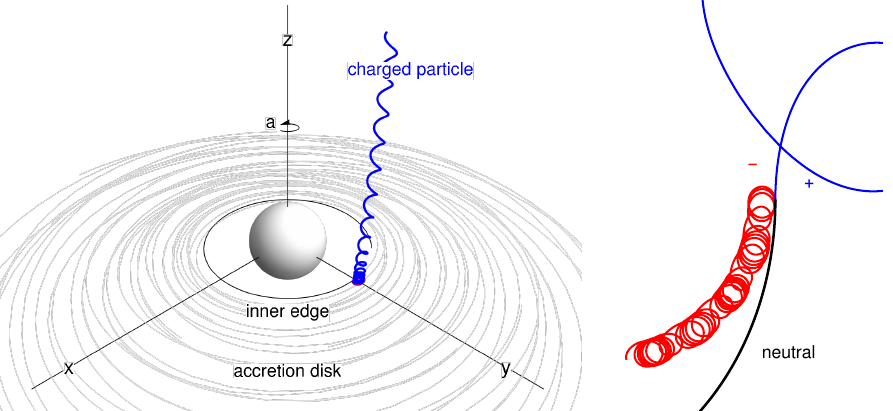
Figure 5. Magnetic Penrose Process for ionized neutral particle. The positively charged particle (proton) escapes into infinity, gaining positive energy from the black hole, while the negatively charge particle (electron) is captured by the black hole, loading to it negative